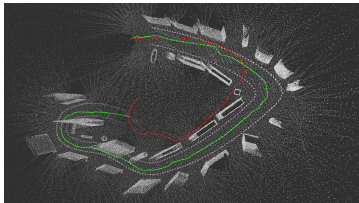
Figure 8. Results of two different estimators in the algorithm top view